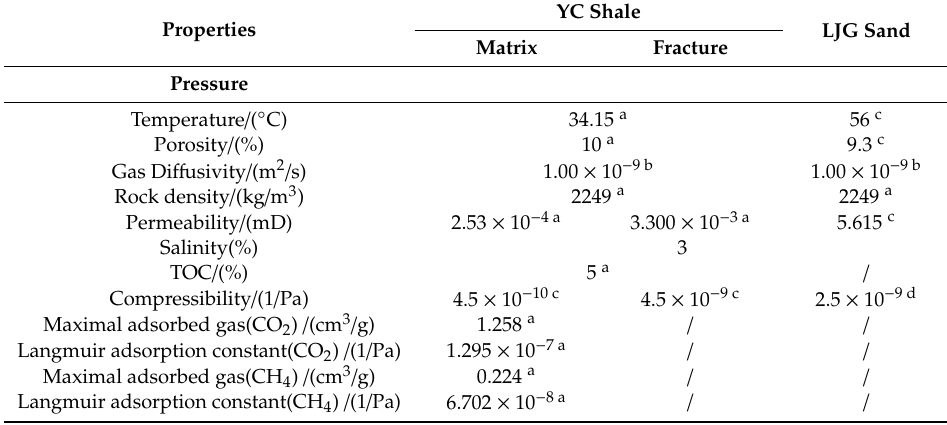
Table 1. Properties of Yanchang shale and the Shenhua saline aquifer used in the